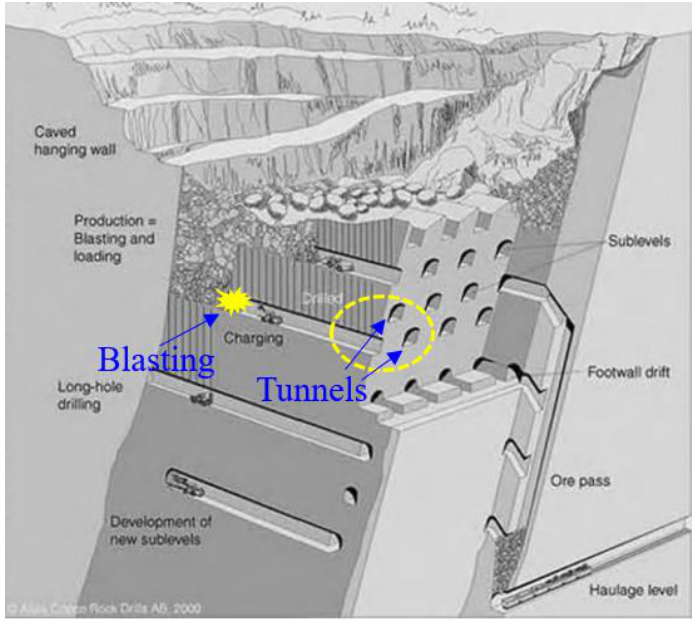
Figure 1. Mining methods in Kiruna Iron Mine in Sweden [36].